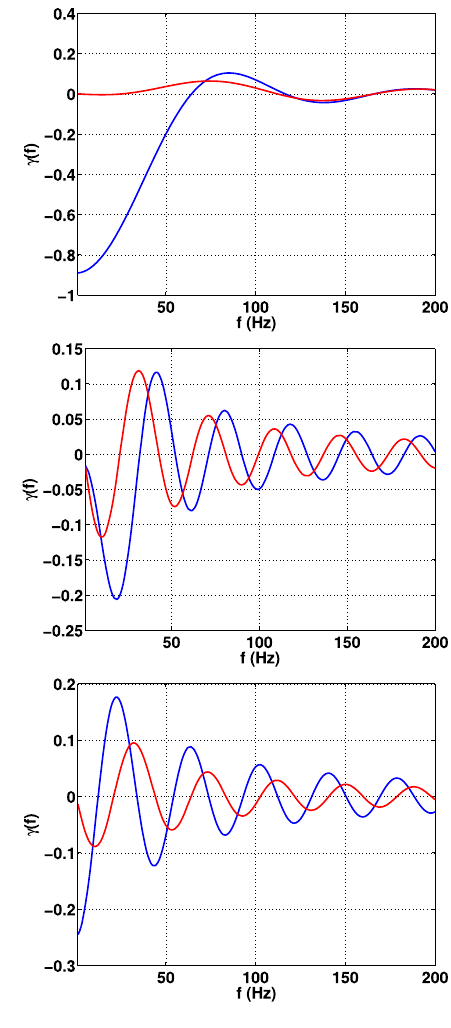
Fig. 61 Normalized overlap functions for the I and V Stokes’ parameters for the LIGO Hanford-LIGO Livingston detector pair ( top panel ); for the LIGO Hanford-Virgo detector pair ( middle panel ); for the LIGO Livingston-Virgo detector pair ( bottom panel ). The I overlap functions are shown in blue ; the V overlap functions are shown in red . Note the change in scale of the vertical